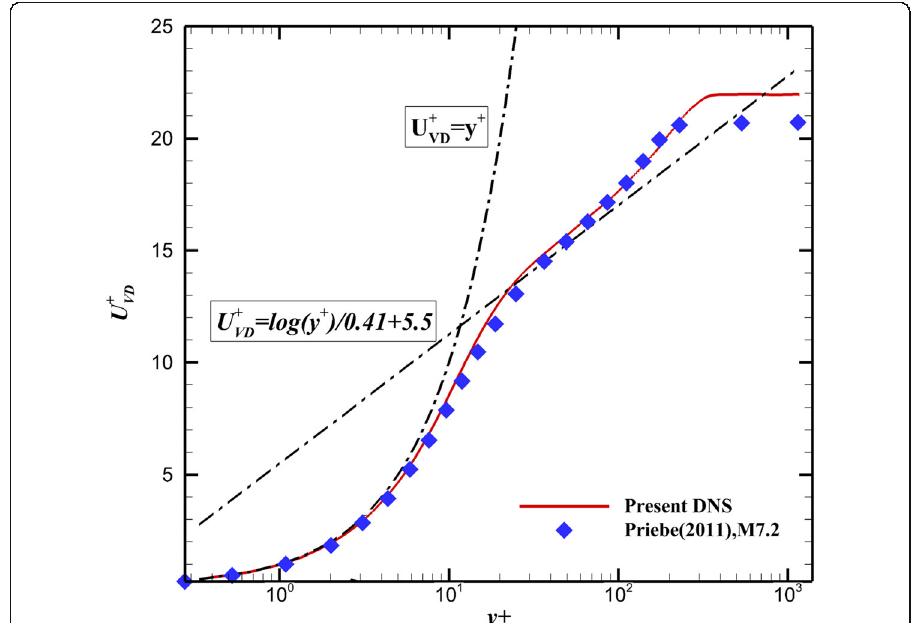
Fig. 3 van Driest transformed mean streamwise velocity